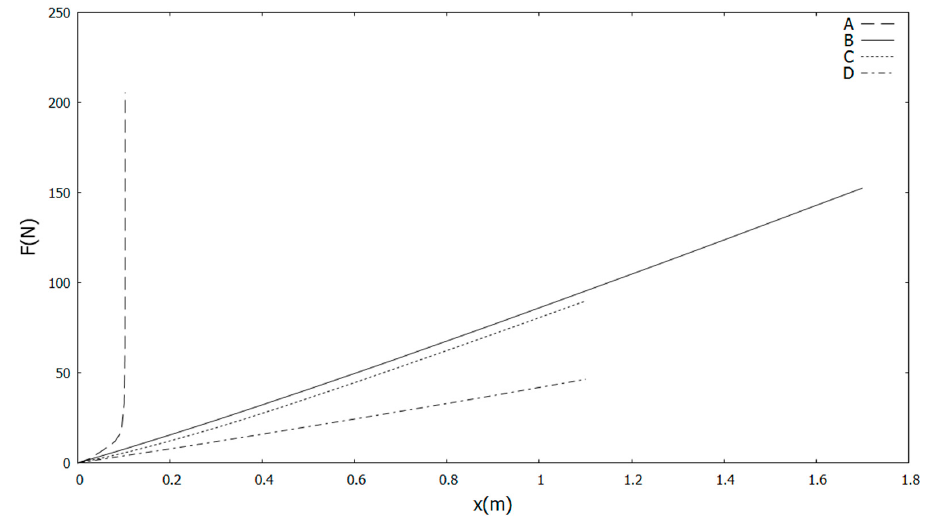
Figure 17. Variation of static mooring force F with displacement x for the four mooring configurations A, B, C, D with cable elastic stiffness of 100 N/m.